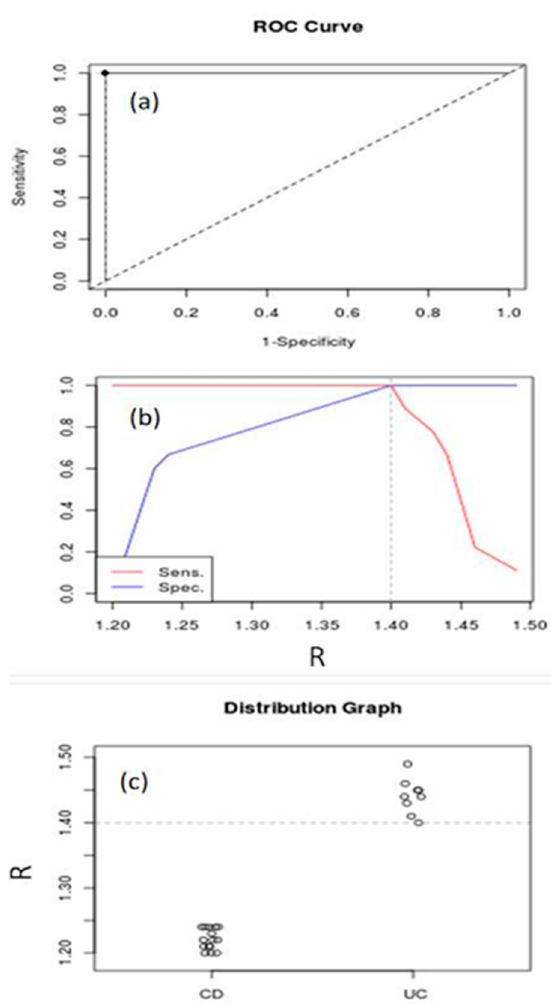
Figure 6. ROC curve ( a ), Youden index and optimal cutoff-point ( b ) and distribution graph ( c ) for UC and CD in IBD subjects.